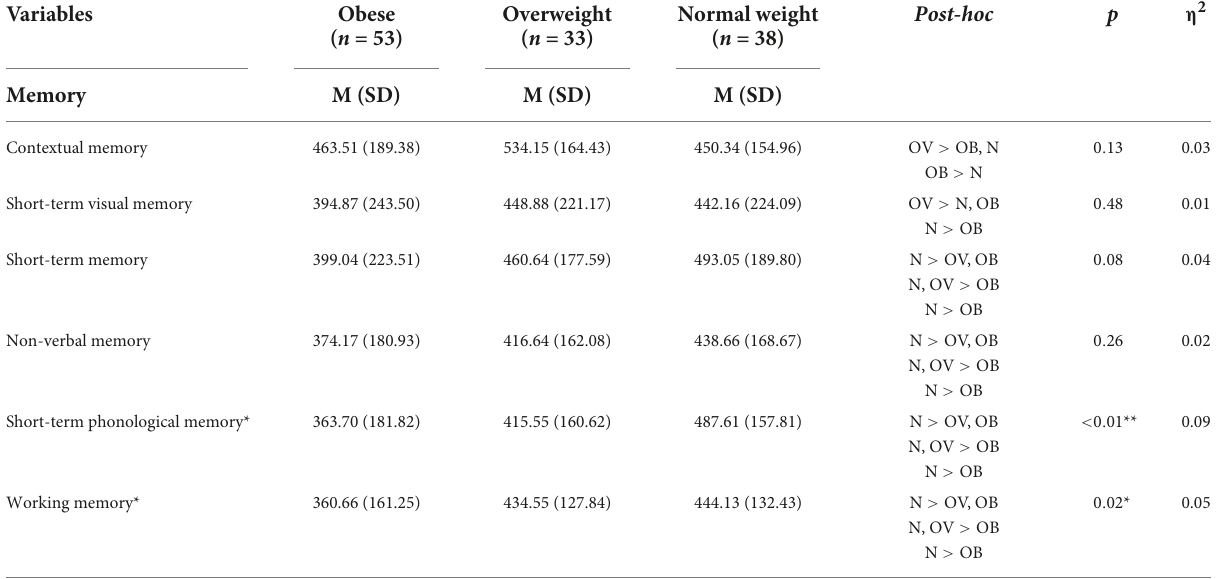
TABLE 4 Means and standard deviations in memory subcomponents for each